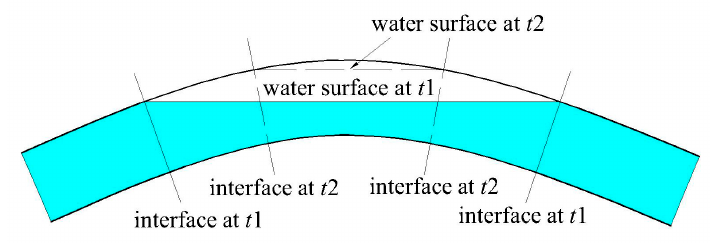
Figure 4. Interfaces of the two parts.